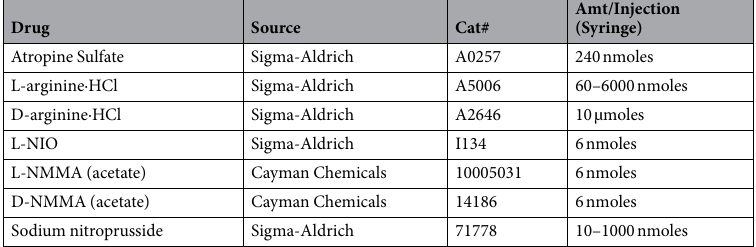
Table 3. Agents employed in the present